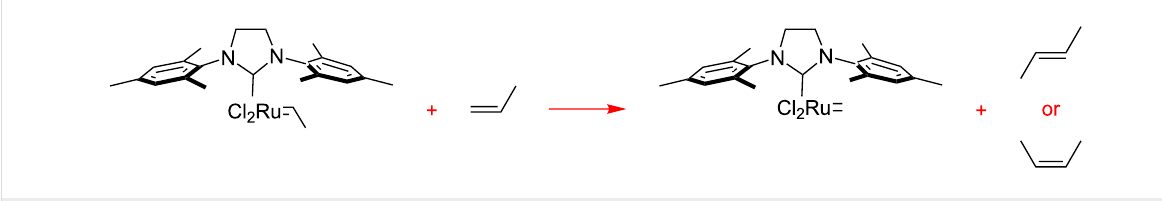
Scheme 2: Representation of the reactions investigated.